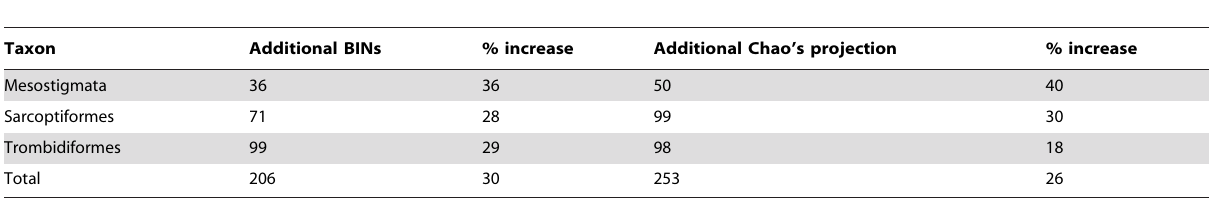
Table 3. Effect of sampling patchy, short-lived habitats.